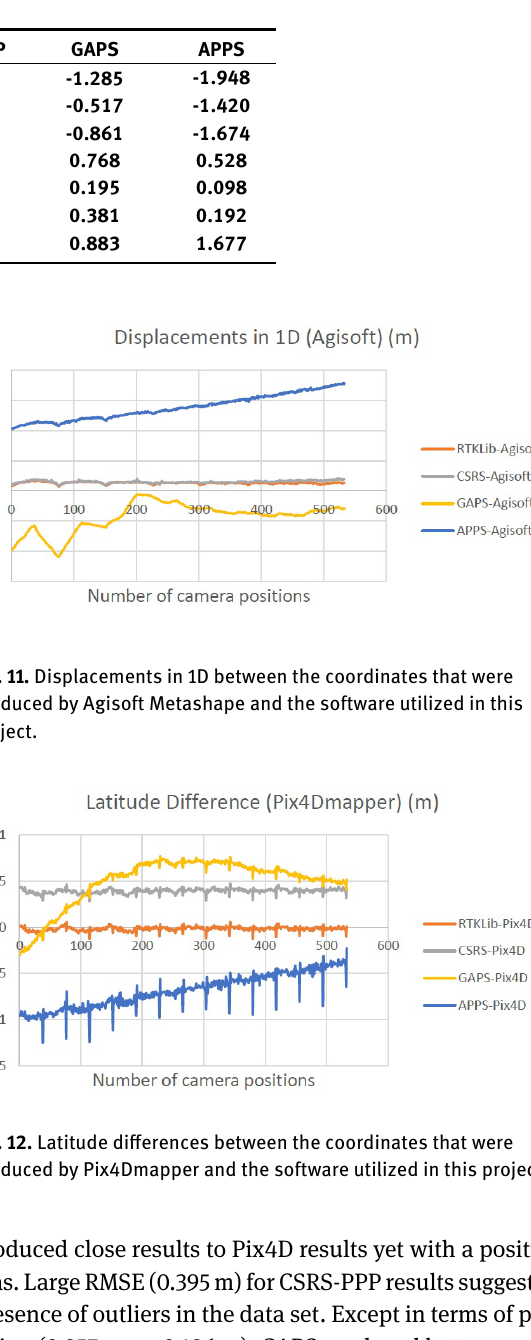
Table 2. Results about longitude differences (Agisoft) (m)